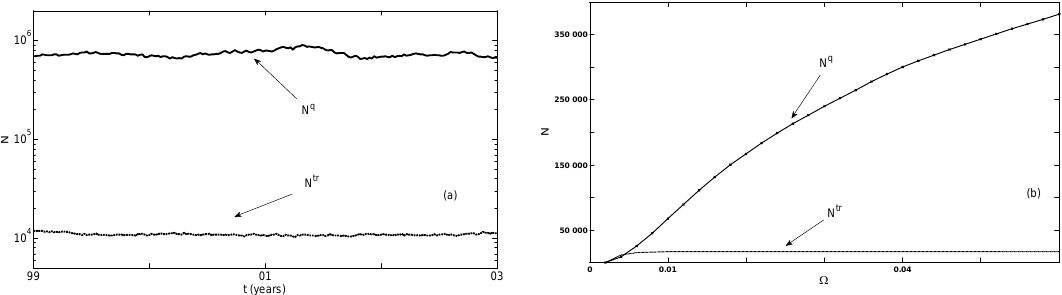
Figure 5. Variability of the number of near-resonance triplets, N tr , and near-resonance quartets, N q , as a function of (a) time and (b) resonance broadening, (cid:127)